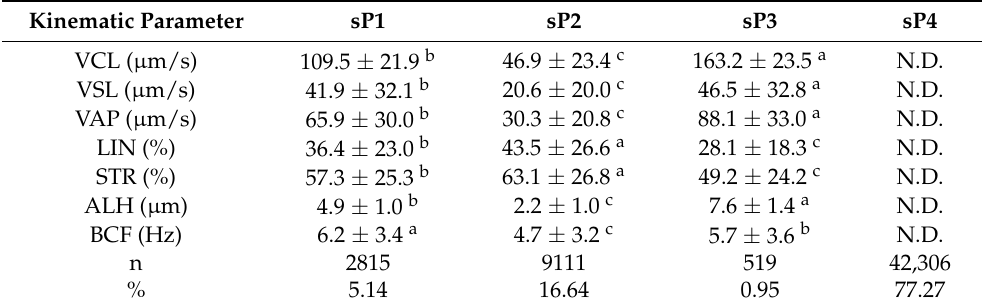
Table 4. Kinematic characteristics of the four sperm subpopulations in thawed buck sperm samples. Kinematic Parameter